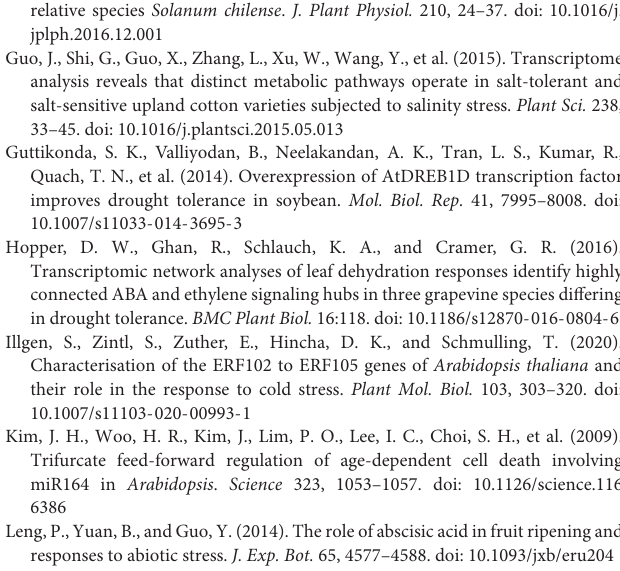
Supplementary Figure 1 | Validation of RNA-seq data by qRT-PCR. Supplementary Figure 2 | Phenotypes of pTRV:ERF12 and pTRV:00 plants under normal conditions. Supplementary Table 1 | Salt tolerance analysis of different cotton cultivars. Supplementary Table 2 | Quality assessment of raw RNA-seq data. Supplementary Table 3 | Gene ontology (GO) analysis of DEGs from ST and SS. Supplementary Table 4 | Differentially expressed genes (DEGs) involving in enriched GO terms. Supplementary Table 5 | Expression of TF and ROS related genes. Supplementary Table 6 | Primers in this